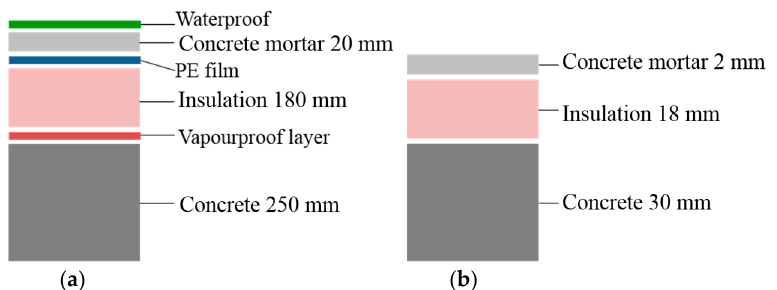
Figure 3. A 1:10 scale model of the flat roof of an actual office building. ( a ) Cross-section of the actual roof; ( b ) Cross-section of the scale model. Energies 2017 , 10 , 195